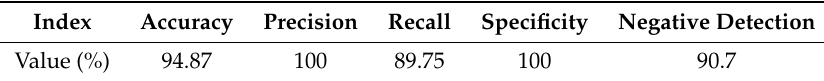
Table 15. Detection evaluation